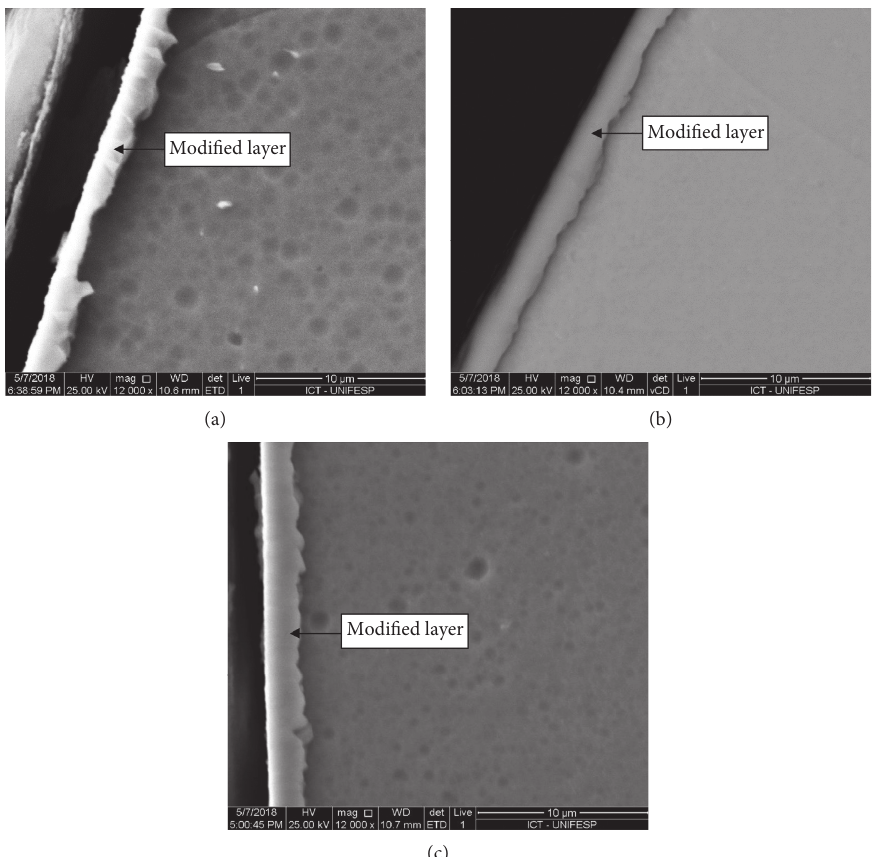
Figure 4: Cross-section view of treated niobium evidencing the modified layers after HT-NPBII performed at 1h (a), 4h (b), and 8h